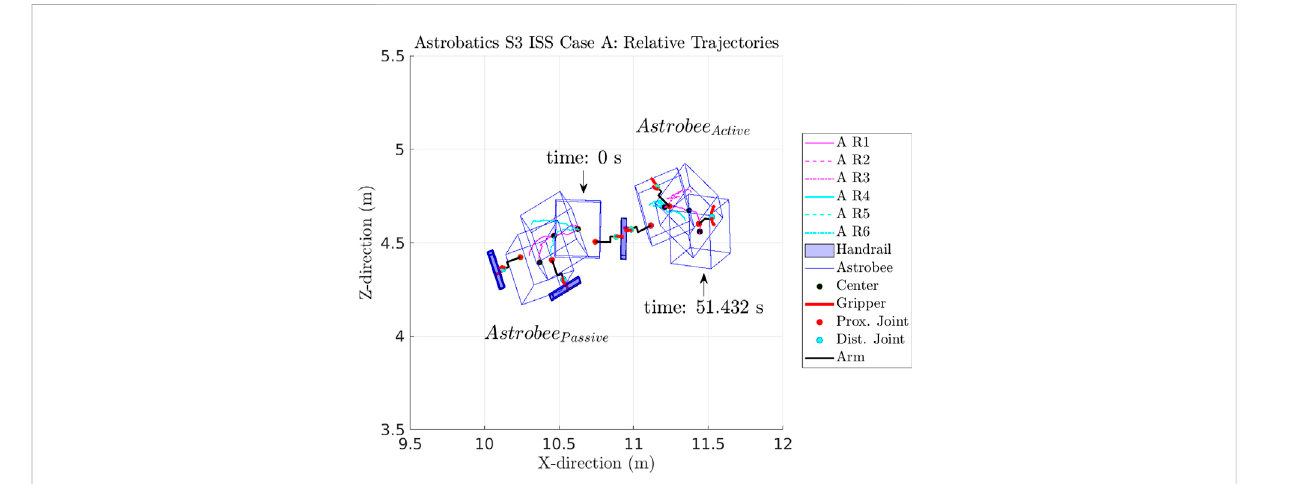
FIGURE 9 Illustration of the six case A runs that were completed with the relative trajectories of each run aboard the ISS.